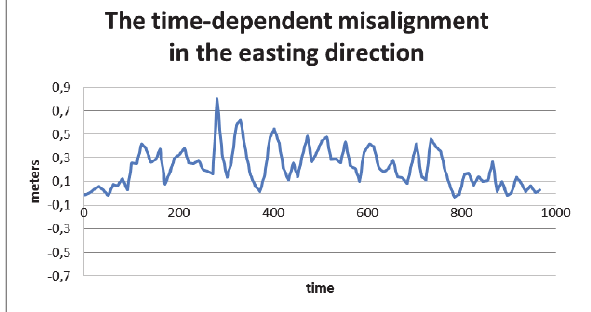
Figure 6. The misalignment of the BLS patch centre points in the easting direction.